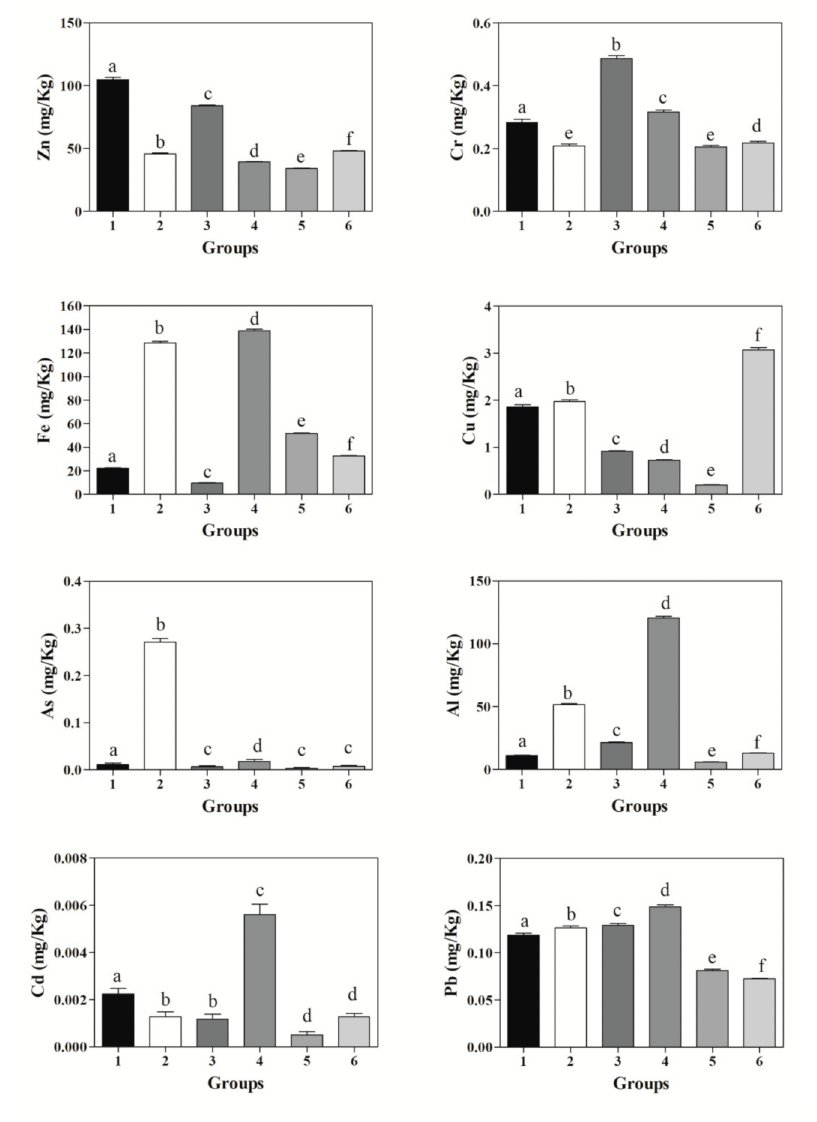
Figure 2. Mean ± standard deviations ( ± SD) of zinc (Zn), chromium (Cr), iron (Fe), copper (Cu), arsenic (As), aluminum (Al), cadmium (Cd), and lead (Pb), together with statistical significances, in the studied six groups. Different alphabetic letters show significant differences among groups ( p < 0.05). The levels of heavy metals measured in each group were lower or within the values reported in previous published papers on cow hair